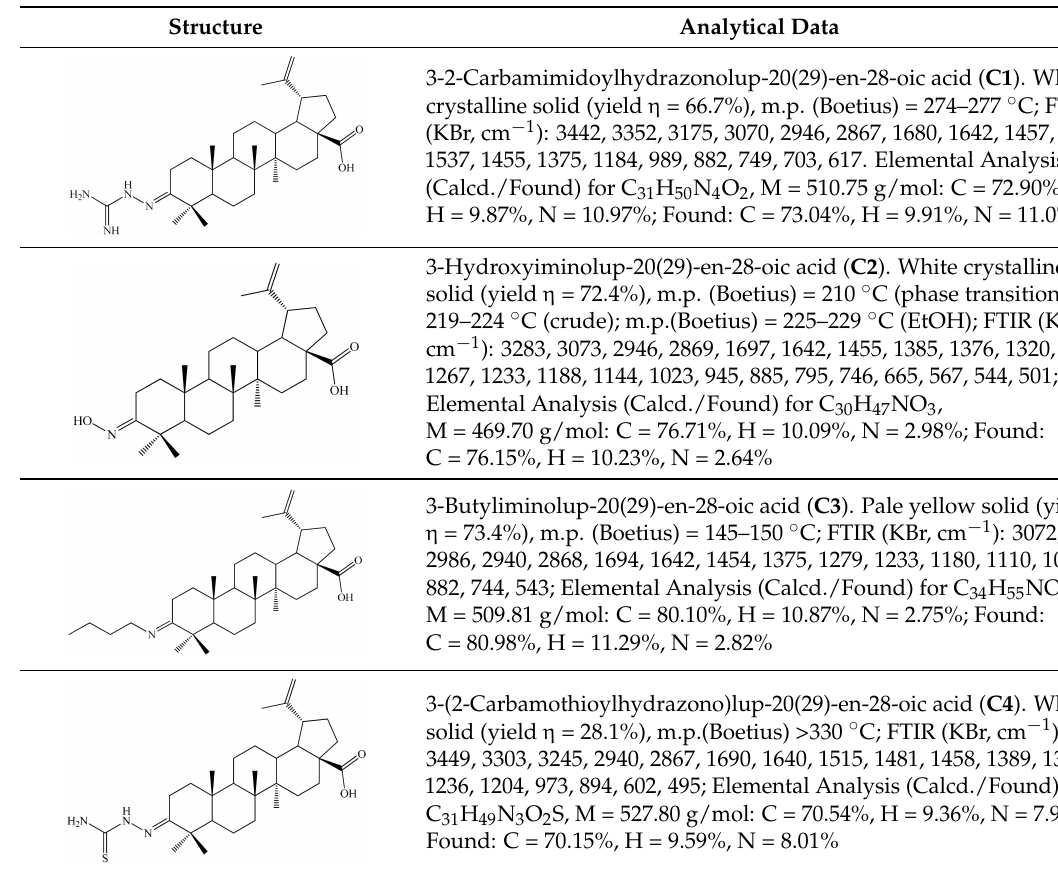
Table 1. The physico-chemical characteristics of the obtained functionalized derivatives C1 – C4 . Structure Analytical